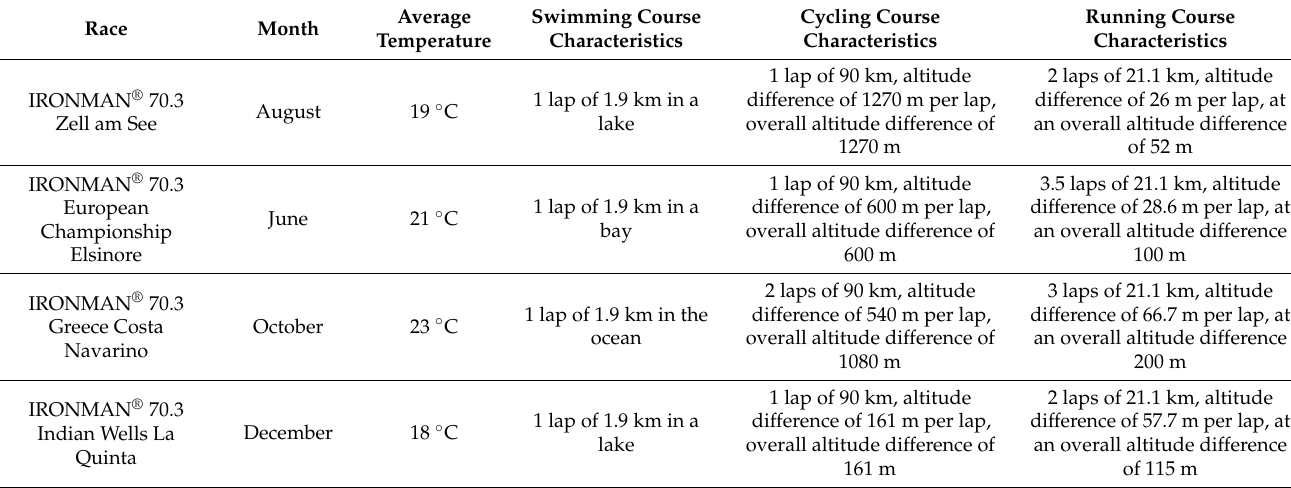
Table 3. Specific descriptions of Ironman ® 70.3 race